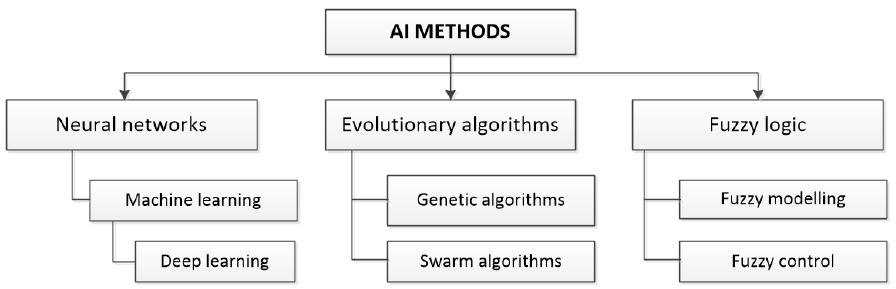
Figure 4. Main directions of AI techniques development in hydraulic system